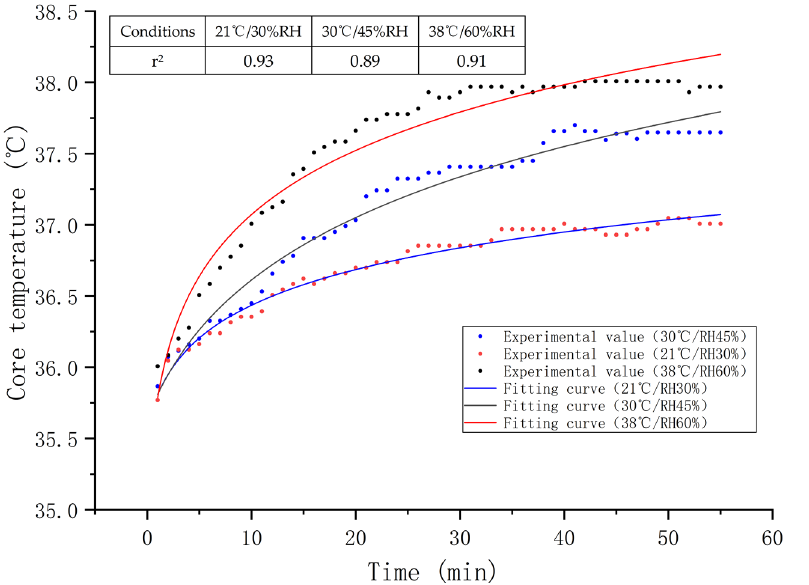
Figure 3. The core temperatures and logarithmic fitting curves versus time under three conditions, and high values of r 2 indicate goodness of fit.